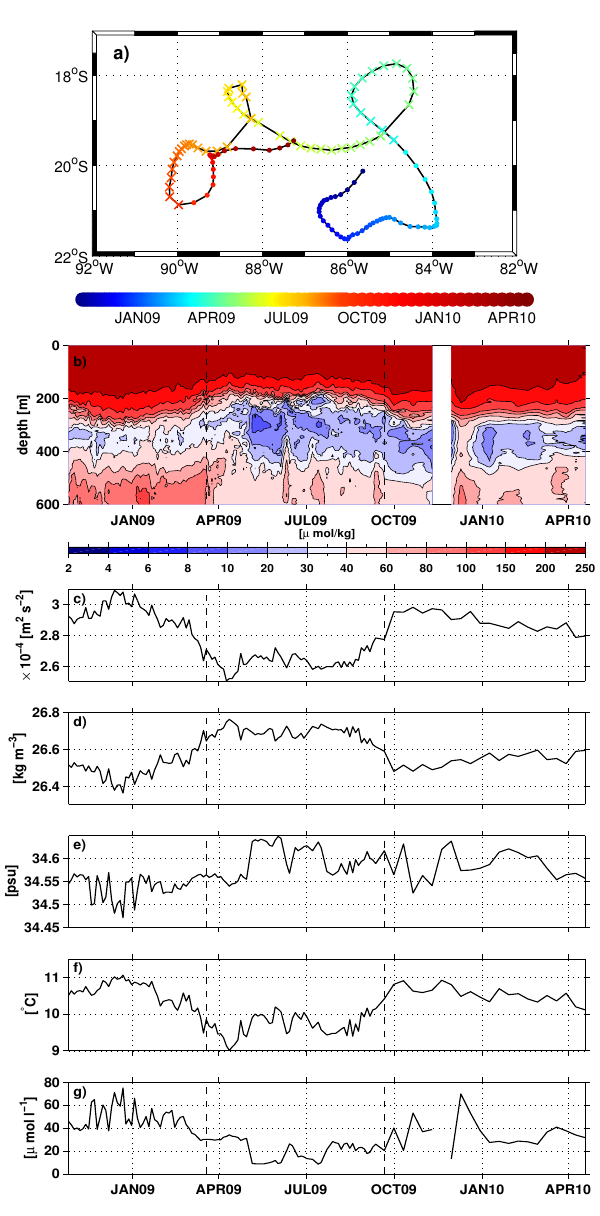
Figure 6. Measurements of float 3900715 in the tropical eastern South Pacific between 26 October 2008 and 19 April 2010 with (a) float path (color coded), (b) oxygen distribution versus time in the upper 600m, (c) geopotential anomaly (450 to 250m, black curve) and SSHA from daily delayed-time satellite data at the float location (red curve), (d) potential density anomaly in 300m depth, (e) salinity in 300m, (f) potential temperature in 300m, and (g) oxy- gen in 300m. An erroneous oxygen profile in early November 2009 was removed. The float residence time of the float in the cyclonic eddy (19 March 2009 to 21 September 2009) is marked by Xs (a) and dashed black lines (b–g)